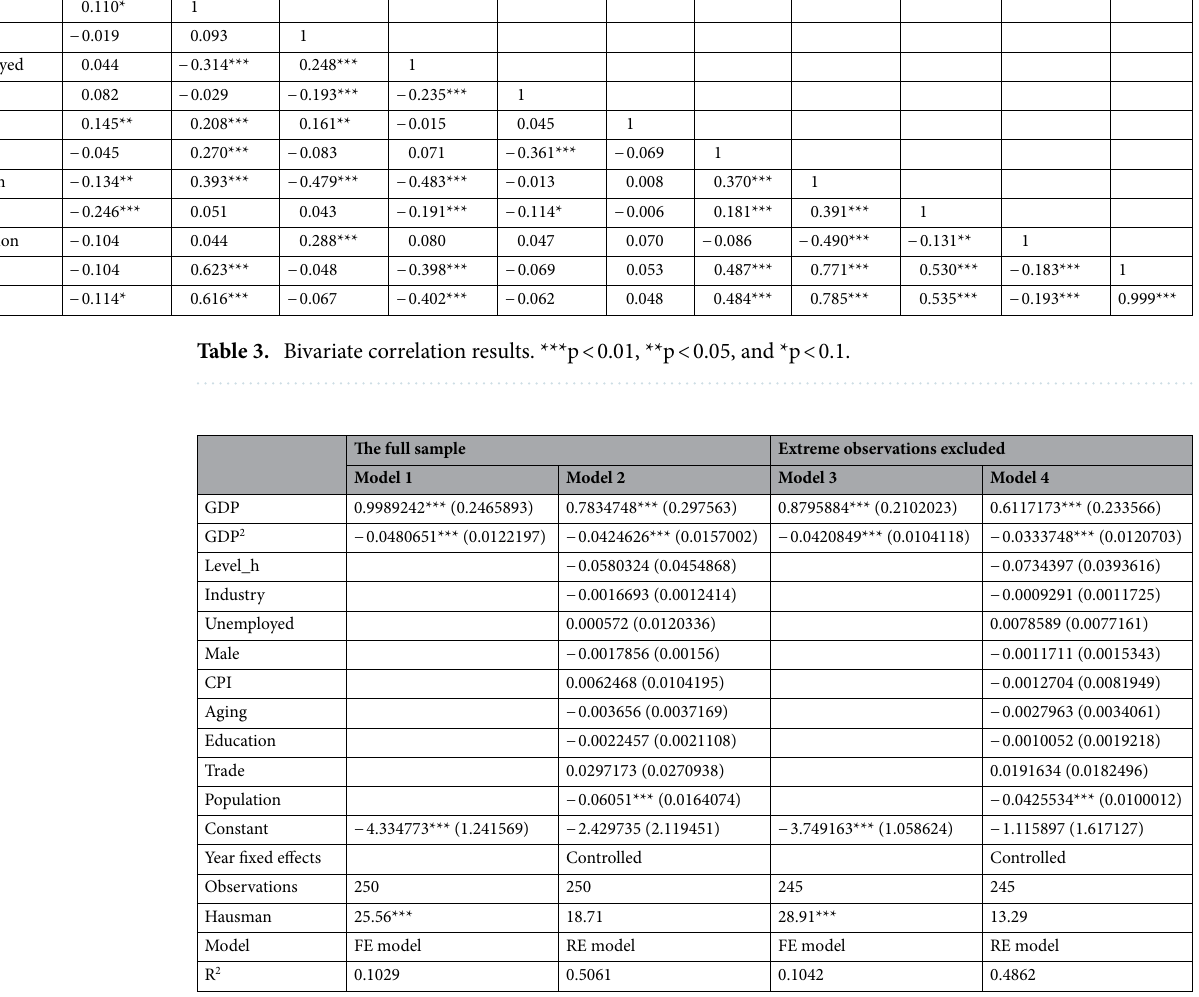
Table 4. Regression results. Robust standard errors are in parentheses. ***p < 0.01, **p < 0.05. Within R 2 is reported for the FE model, and overall R 2 is reported for the RE